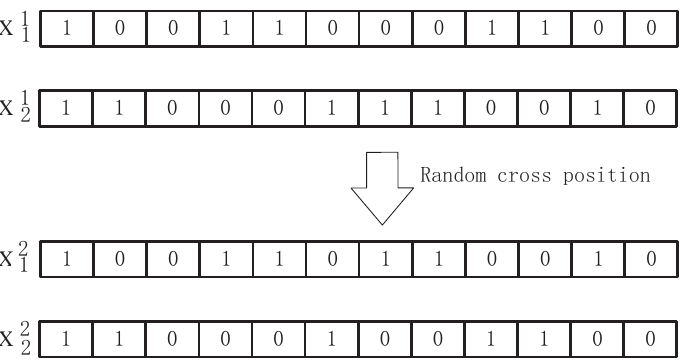
Figure 2. Schematic diagram of binary encoding crossing. For the setting of crossover and genetic probability parameters, different parameter selection has different effects on the quality of the algorithm, but the setting of parameters at present mainly depends on the experience of predecessors. The mutation process is shown in Figure 3.